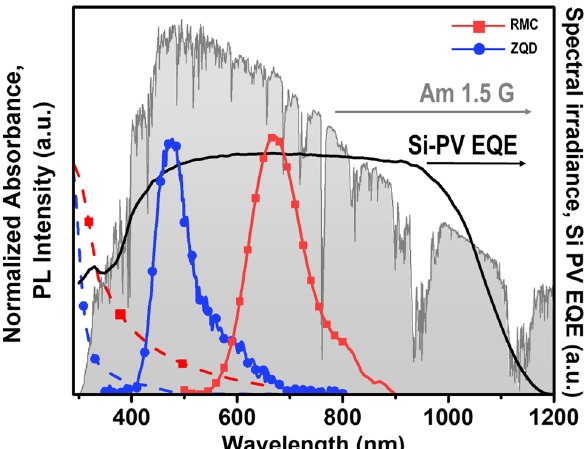
Figure 2. Normalized absorption (dashed line) and PL (solid line) spectra of RMC (red square) and ZQD (blue circle) dissolved in an argon-saturated tetrahydrofuran solution. AM 1.5 G solar spectrum (gray shading) and a silicon-PV EQE spectrum (black solid line) are